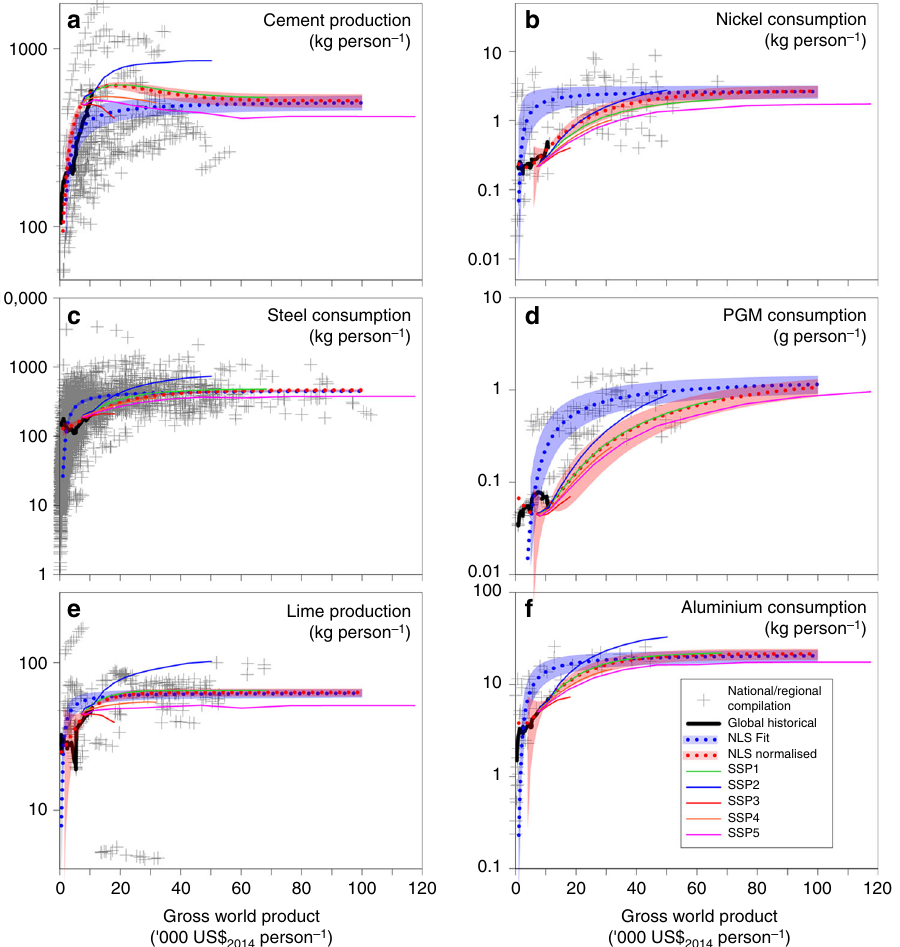
Fig. 1 Consumption/production global saturation estimates for alkaline materials. a Cement, b nickel, c steel, d platinum group metal (PGM), e lime and f aluminium as a function of gross world product (GWP). The diagrams show a nonlinear least squares regression through compiled national data (blue dotted, the shading represents ±the standard error). The saturation value from this was fi xed in an additional regression using global data relative to 2014 consumption (red dotted). Using the global fi t as a baseline, the relative consumption projections for the shared socio-economic pathways (SSPs) were derived by normalising absolute changes in consumption. Production has been used for lime and cement that have a relatively small international trade market (<5%), otherwise apparent consumption has been plotted using national (slag) or regional (aluminium, PGM, nickel)